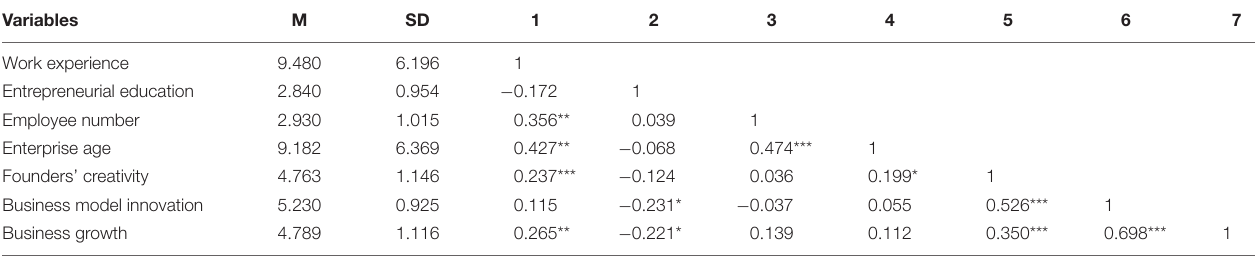
TABLE 3 | Descriptive statistics and correlation matrix for the variables.